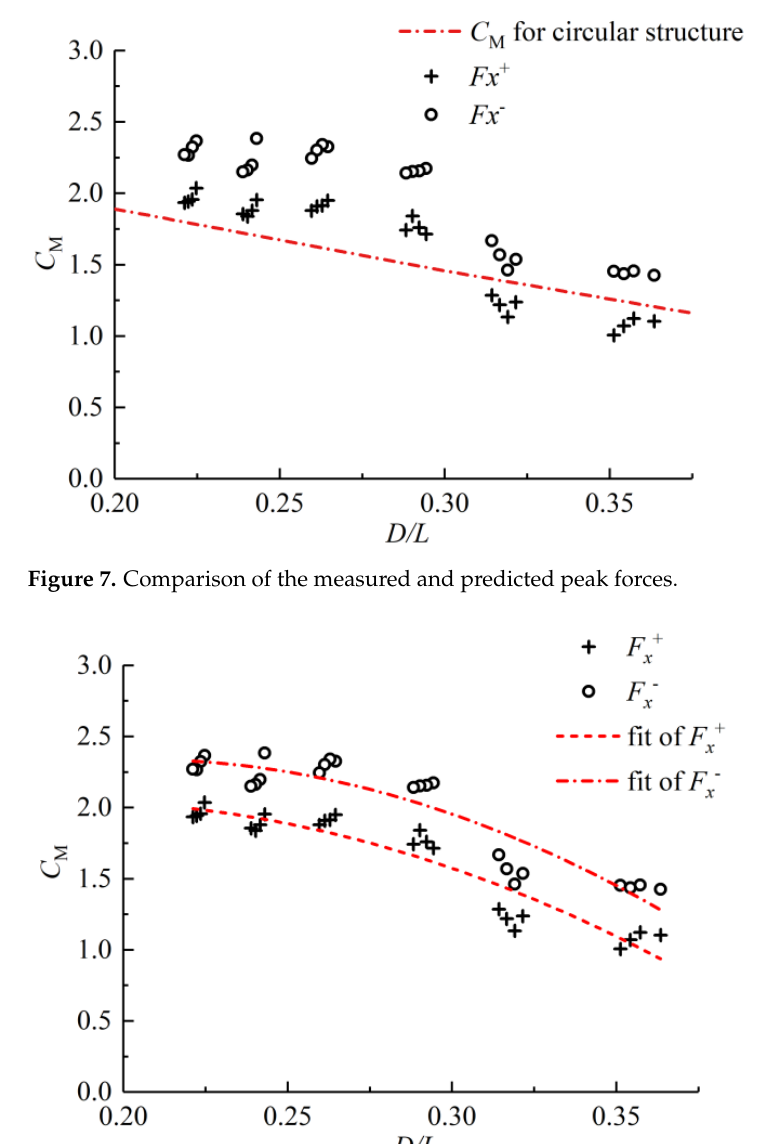
within 0.2~0.4 for practical ocean engineering.